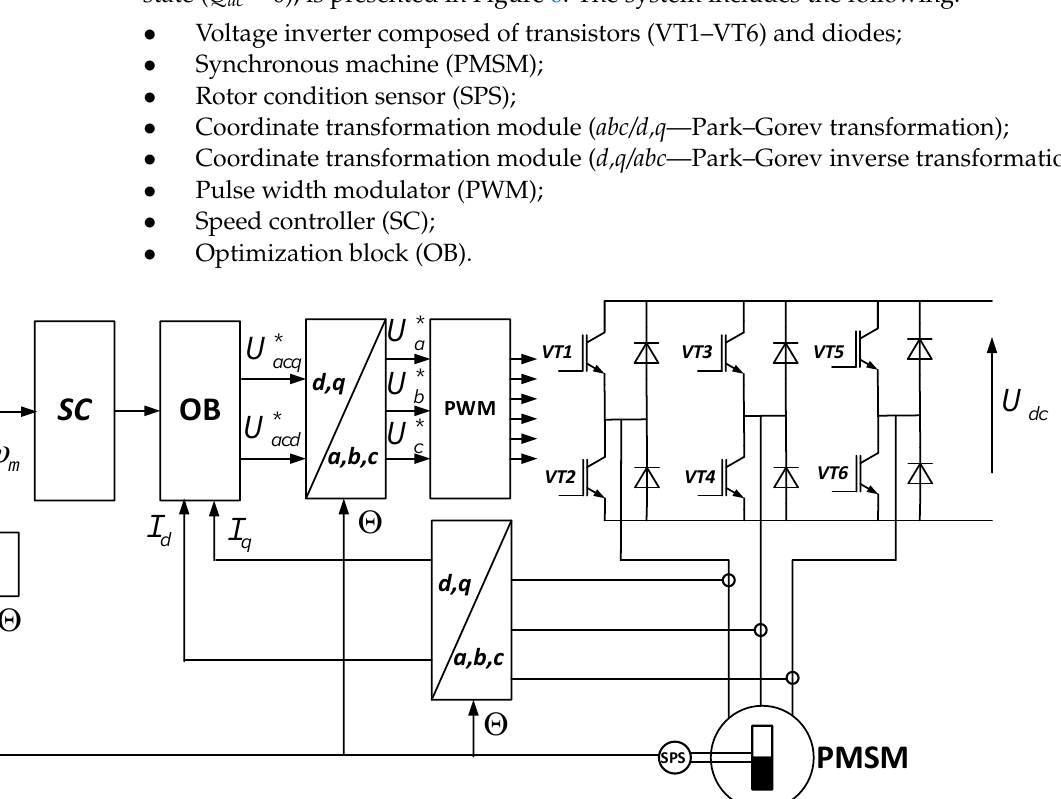
Figure 5. Energy characteristics: ( a ) active power P ac and ( b ) reactive power Q ac with optimization.